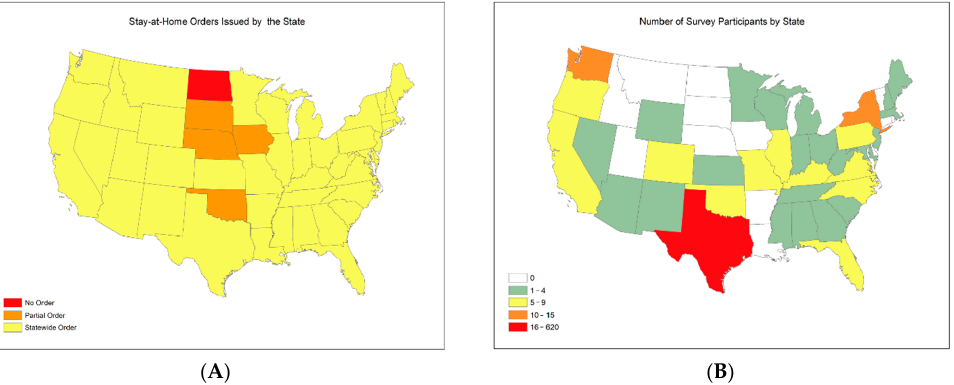
Figure 2. Stay-at-home orders issued state and geographical distributions of survey participants. ( A ). Stay-at-home orders issued by states between March and May 2020. ( B ). Geographical distribution of survey participants across